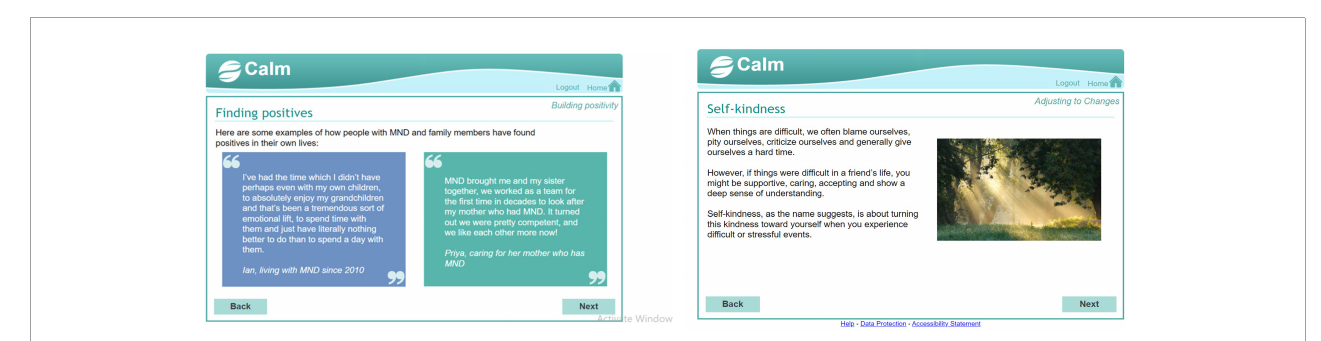
FIGURE4 Example 2 of pages from the CALM website.